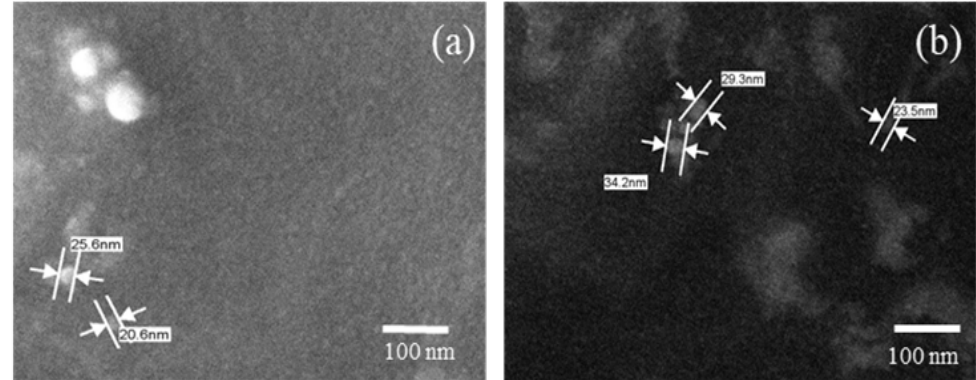
Figure 1. Photomicroscopy of the micelles: ( a ) micelle without curcumin and ( b ) micelle with curcumin, 100,000× magni- fication.